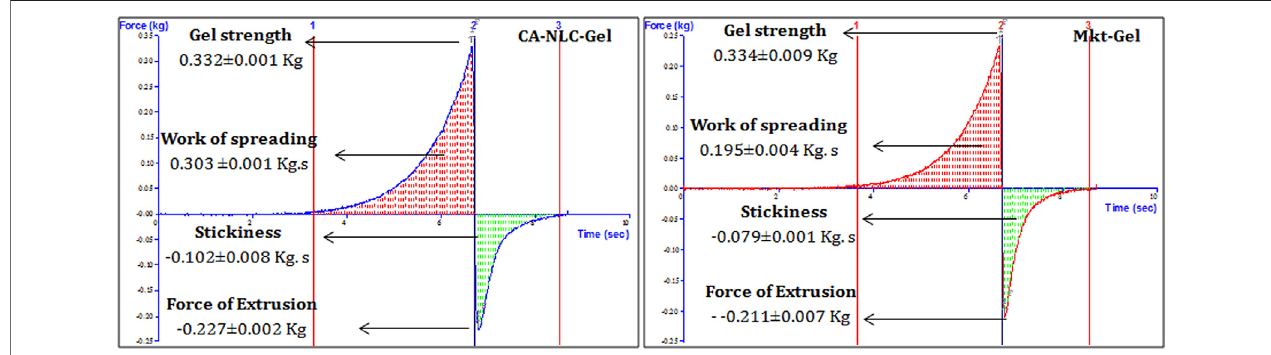
FIGURE 3 | Comparative TPA of CA-NLC-gel and Mkt-gel